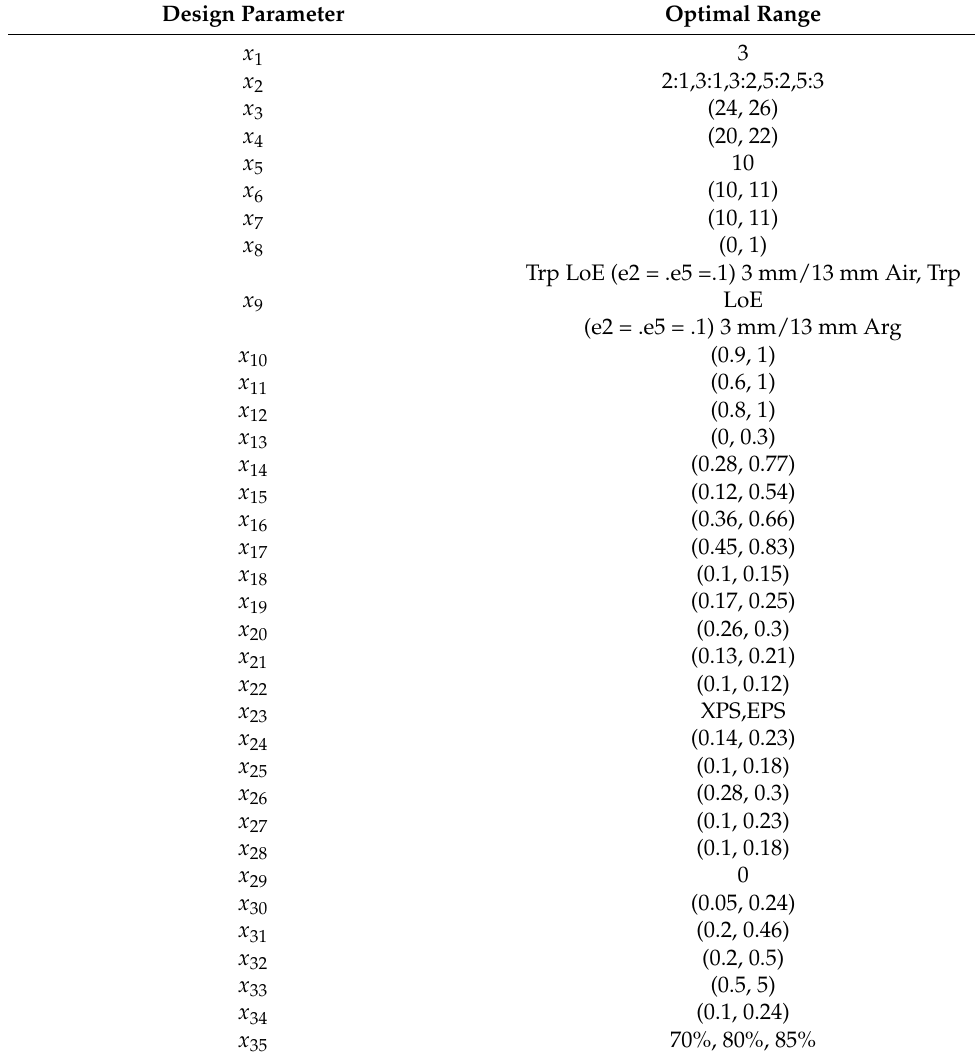
Table 9. The optimal design parameter ranges recommended by the MOALO algorithm. Design